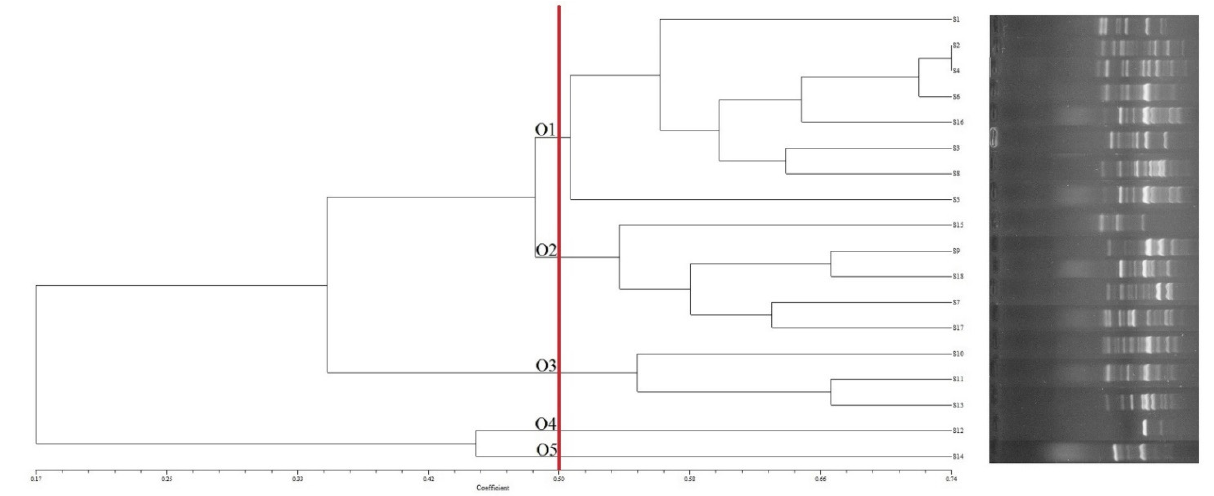
Figure 2. UPGMA dendrogram of the C. perfringens isolates from the raw meat samples based on the OPA-3 PCR analysis.